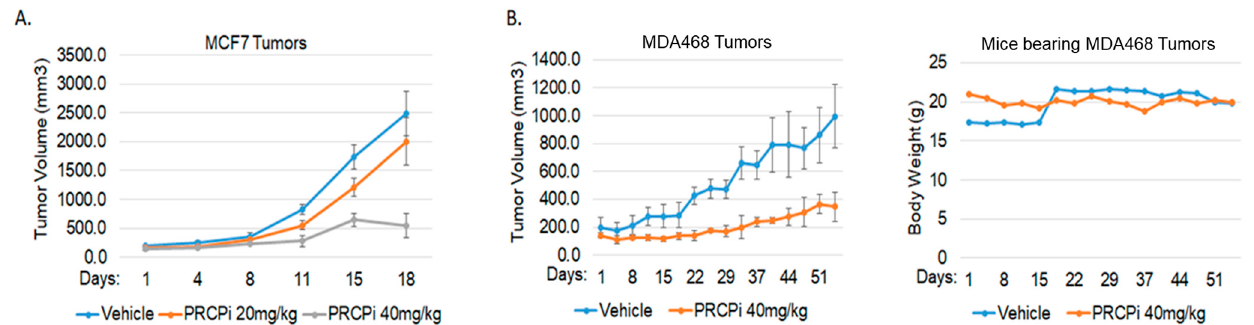
Figure 4. PRCPi suppresses BC tumor growth. ( A ) NSG mice bearing MCF7 tumors were divided to 3 groups and treated daily with a vehicle or PRCPi (20 mg/kg/day or 40 mg/kg/day). Tumor growth (volume) is presented +/ − SE. There is a significant difference between the vehicle- and PRCPi- (40 mg/kg) treated mice ( p < 0.05). ( B ) SCID mice bearing MDA468 tumors were divided to 2 groups and treated daily with a vehicle or PRCPi (40 mg/kg/day). There is a significant difference between the vehicle- and PRCPi-treated mice ( p < 0.05). Weight of mice during treatment is plotted on the right.